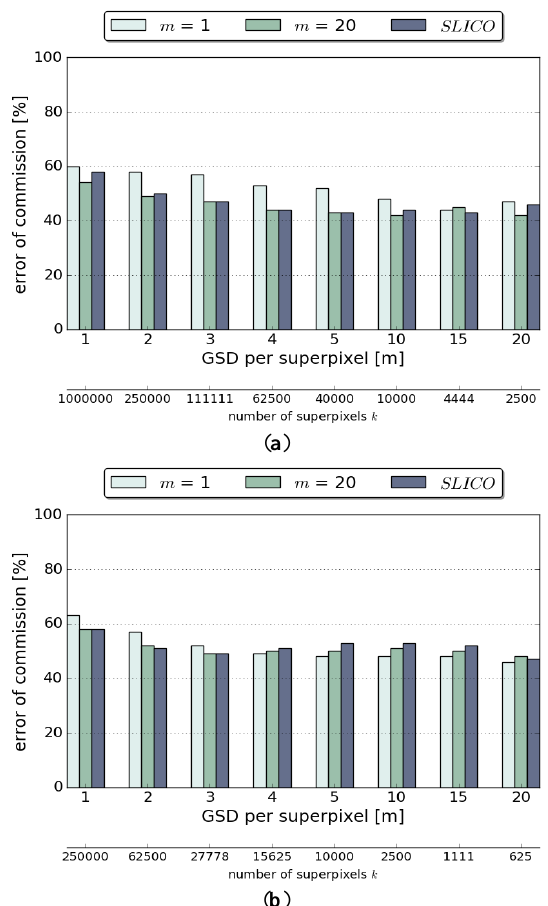
Figure 5. Errors of commission obtained for ( a ) Amtsvenn and ( b ) Toulouse. The number of superpixels k varies according to the extent covered per study area (Table